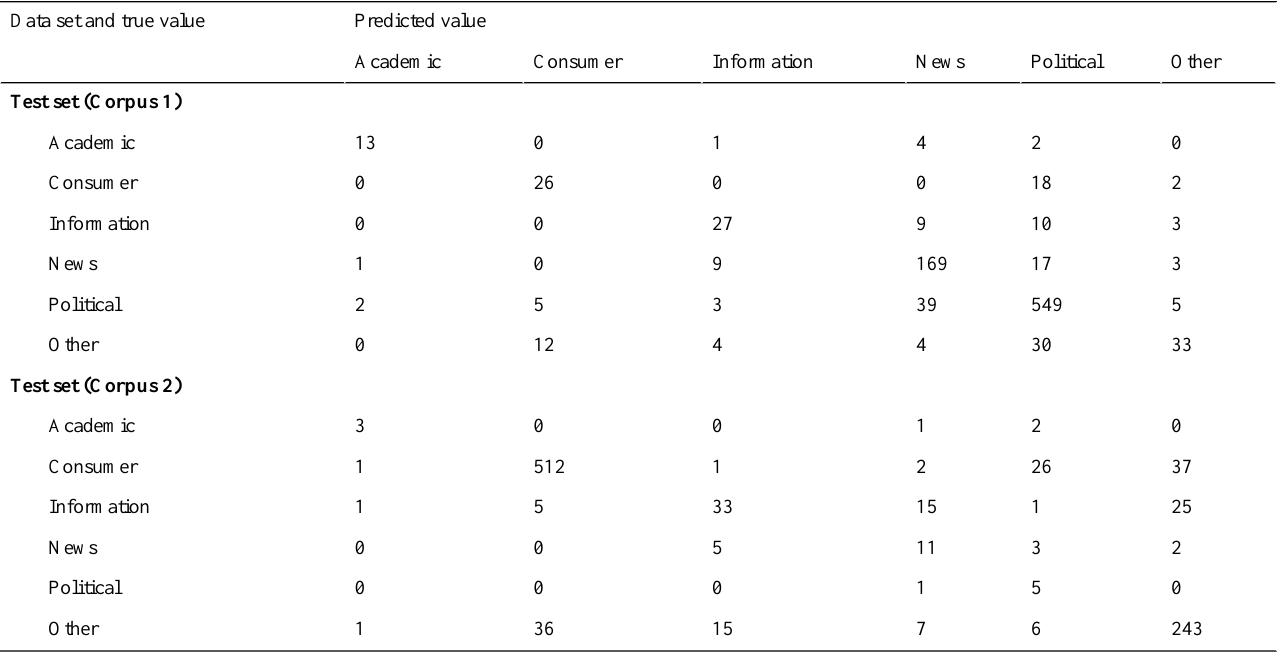
Table 3. The BERT classifier’s confusion matrix on the test set